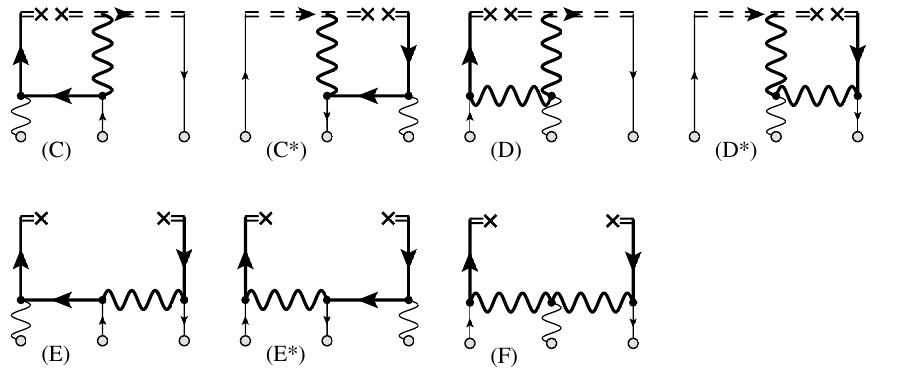
Figure 3 . The non-vanishing diagrams with two insertions of background (cid:12)elds. The bold lines denote the propagators of quantum (cid:12)elds. The thin lines with bubbles are background (cid:12)elds. The double dashed lines are Wilson lines and crosses show that they are pointing to light-cone in(cid:12)nity.